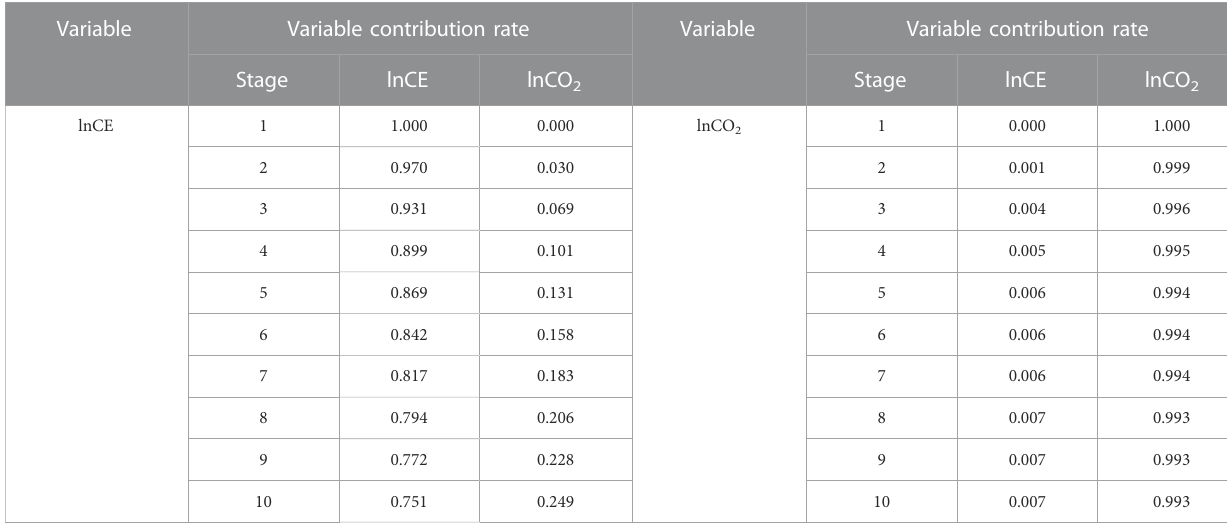
TABLE 8 Variance